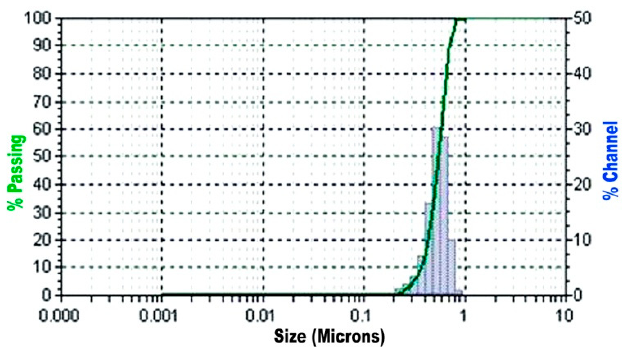
Figure 2. Particle size distribution results of fine aggregate.